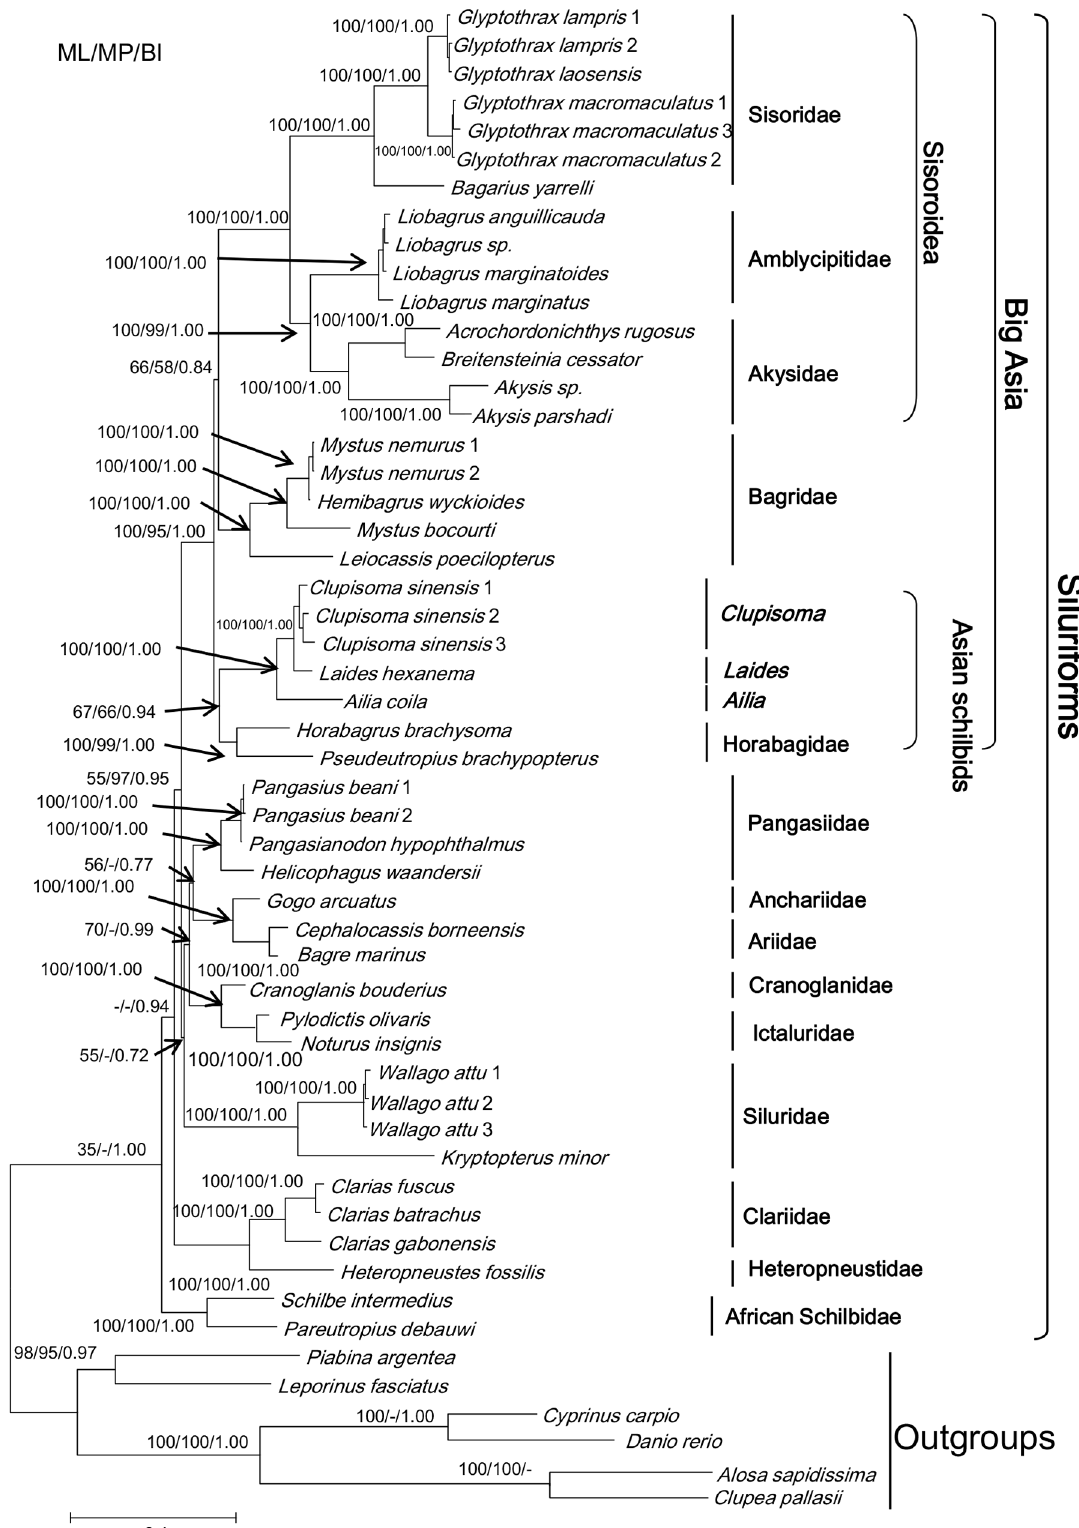
Fig 2. Phylogenetic relationships of the Siluriformes based on ML, MP and BI analysis of the concatenated datasets of nuclear genes. Nodal support values are indicated on the branch. The names Sisoroidea and “ Big Asia ” are after Sullivan et al . (2006) [8]. doi:10.1371/journal.pone.0145675.g002 PLOS ONE | DOI:10.1371/journal.pone.0145675 January 11,